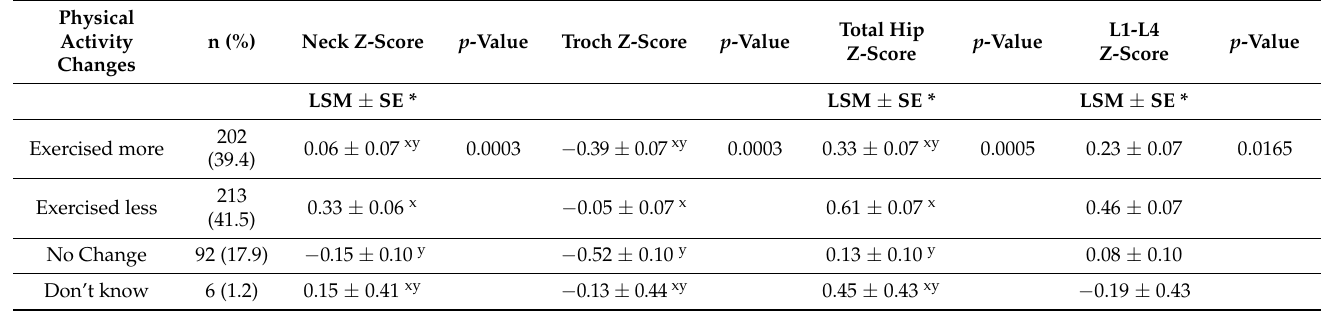
Table 3. Difference of BMD Z-score at each measurement site among physical activity changes (Mixed Model ANOVA) (N = 513).